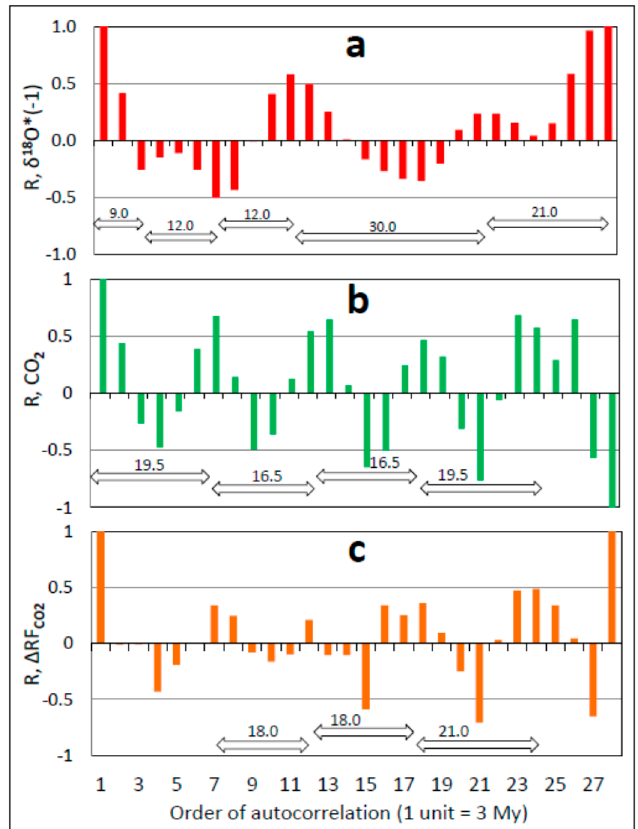
Figure 13. As in Figure 12, but over the shorter time period from 174 to 87 Mybp. Average cycle durations: ( a ) 16.8 My ( b ) 18.0 My ( c ) 19.0 My. Otherwise as in the legend of Figure 12.